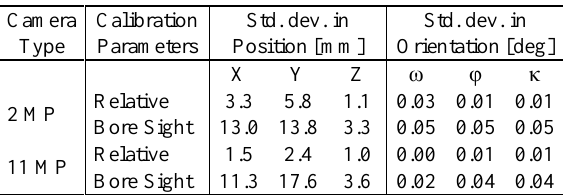
Table 1. Calibration